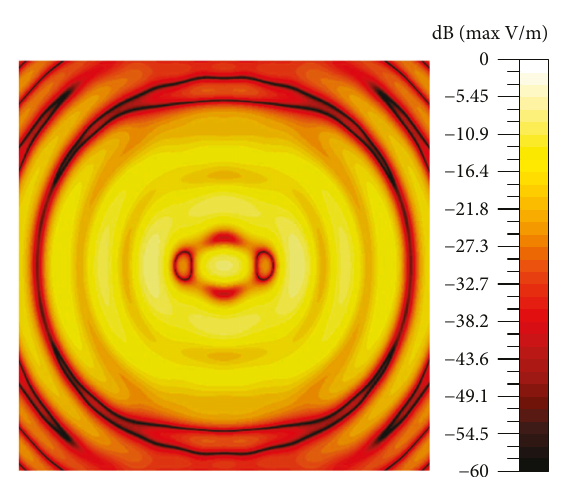
Figure 13: Simulated scattered fi eld copolar amplitude distribution plot at z =45mm plane (behind the feed).